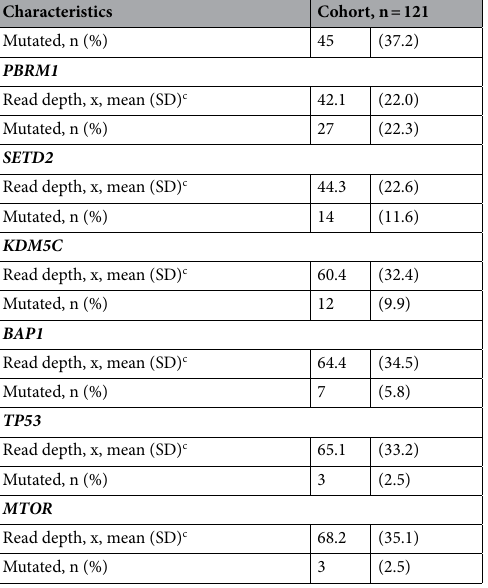
Table 1. Characteristics of ccRCC cases in the Netherlands Cohort Study on diet and cancer (1986–2008). a According to the TNM Classification of Malignant Tumours. Third Edition, Revised Edition 24 . b Longest DNA fragment detected using a DNA fragment ladder test. c Uniquely aligned reads based on the UMI-based custom panel kit (Ovation™ Custom Target Enrichment System, NuGEN, San Carlos, CA, USA).